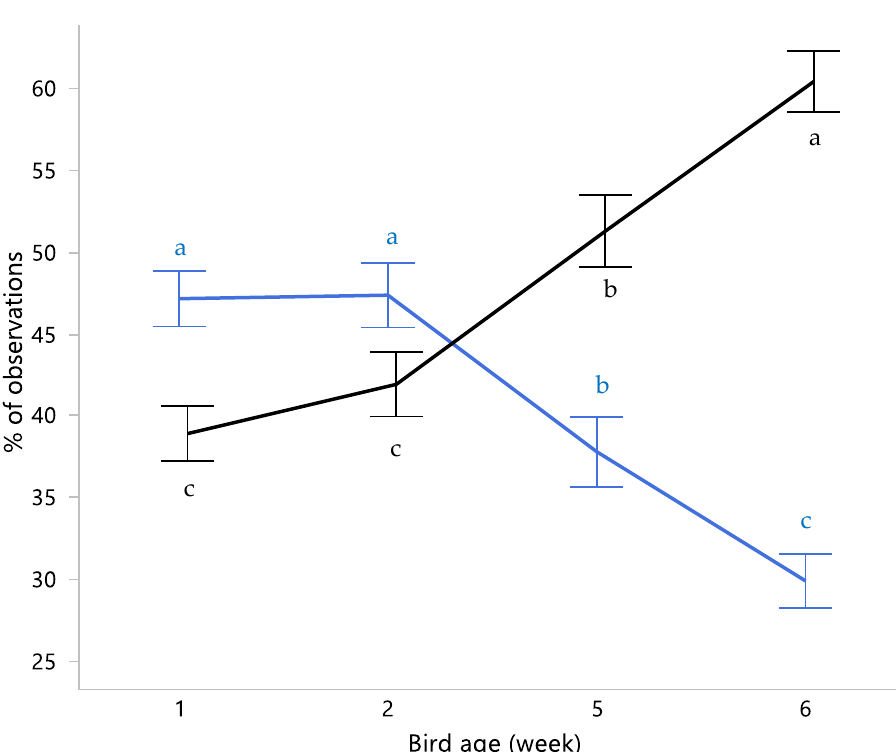
Figure 3. Percentage (means ± SEM) of observations that birds were active (sum of all active behaviors; in blue) or passive (in black) in week 1, 2, 5 and 6. Percentages of active and passive behaviors do not sum to 100% as “out of view” and “other” were excluded from the calculations. Means within a behavioral category without common superscripts differed at p < 0.05.